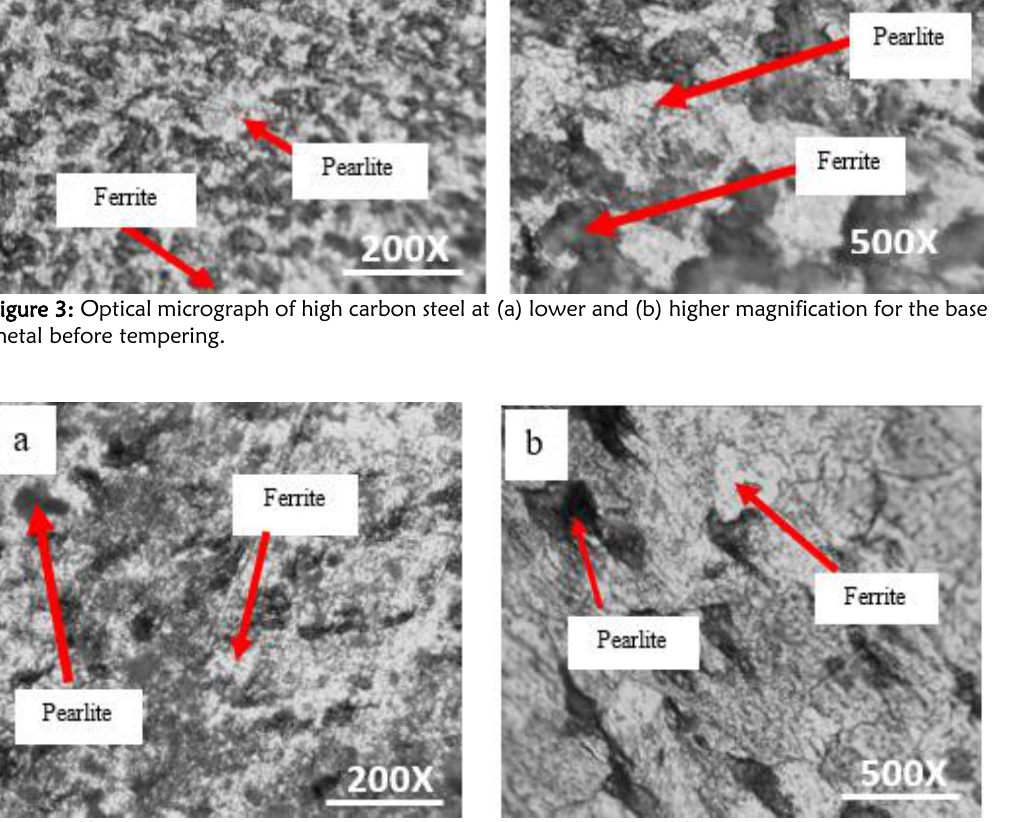
Figure 4: Optical micrograph of medium carbon steel at (a) lower and (b) higher magnification for the base metal before tempering.